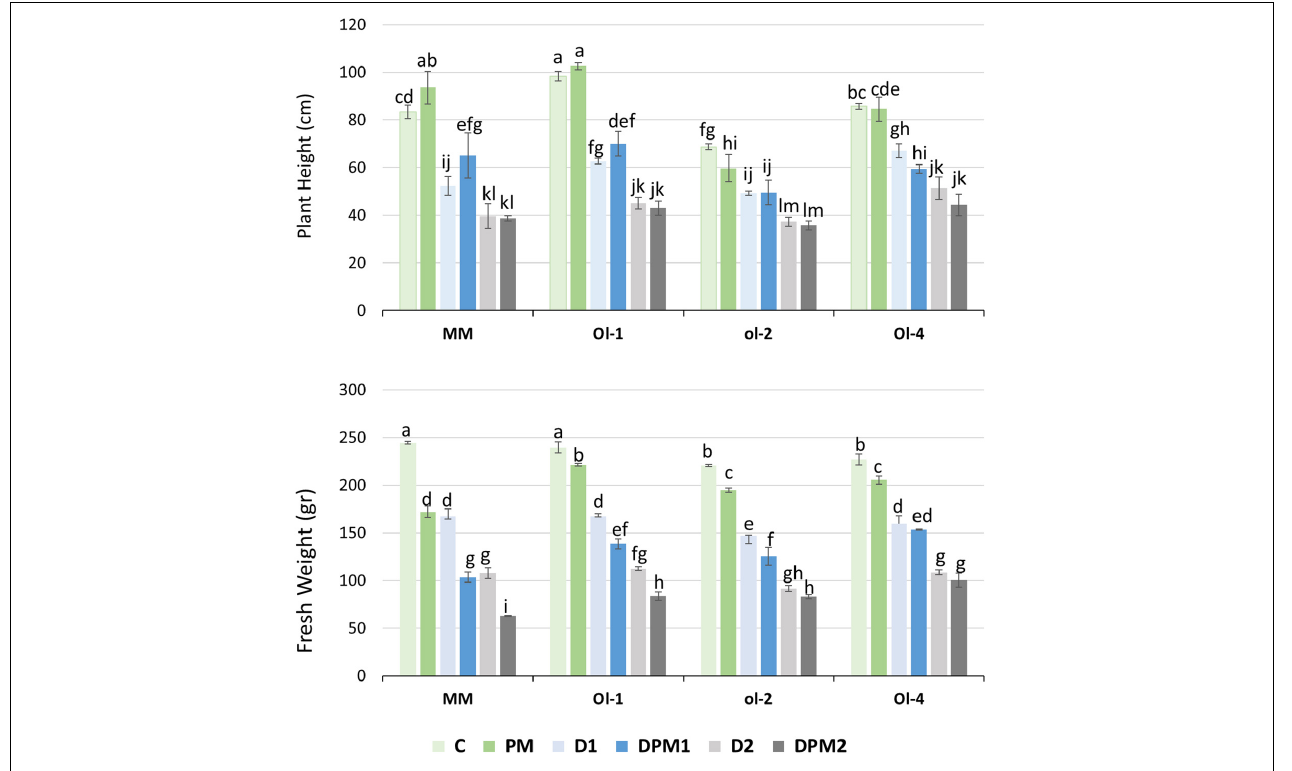
FIGURE 1 | Plant height and shoot fresh weight under control conditions (C), mild drought stress (D1), severe drought stress (D2), powdery mildew (PM) infection (PM), combined D1 and PM (DPM1), and combined D2 and PM (DPM2). Data represent means ± SEM of three biological replicates. Different letters indicate significant differences ( P < 0.05) compared to Moneymaker (MM) under control